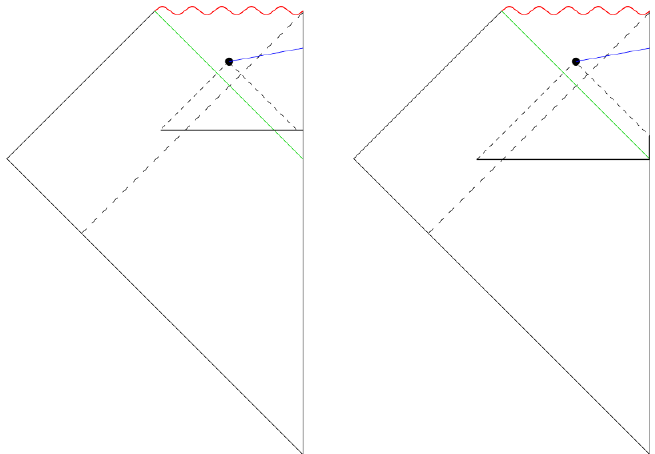
Figure 8 . Equivalent reconstructions for operators behind the new black hole horizon and to the future of the shock (region IV). Left : we can use the retarded Green’s function to write (cid:8) in terms of bulk operators in regions I, II and III. Right : we can use the retarded Green’s function to evolve to the t = 0 slice where we can write (cid:8) in terms of operators in regions I and II as well as boundary operators in the new geometry.